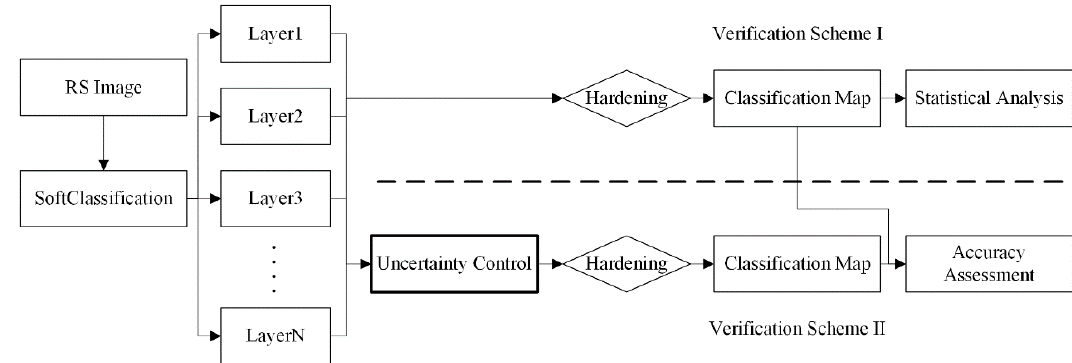
Figure 4 . Flow chart of two verification schemes (LayerN represents the probability map that the image is classified into the N- th class in the soft classification results, and “Hardening” represents the hardening process of soft classification results based on the principle of maximum